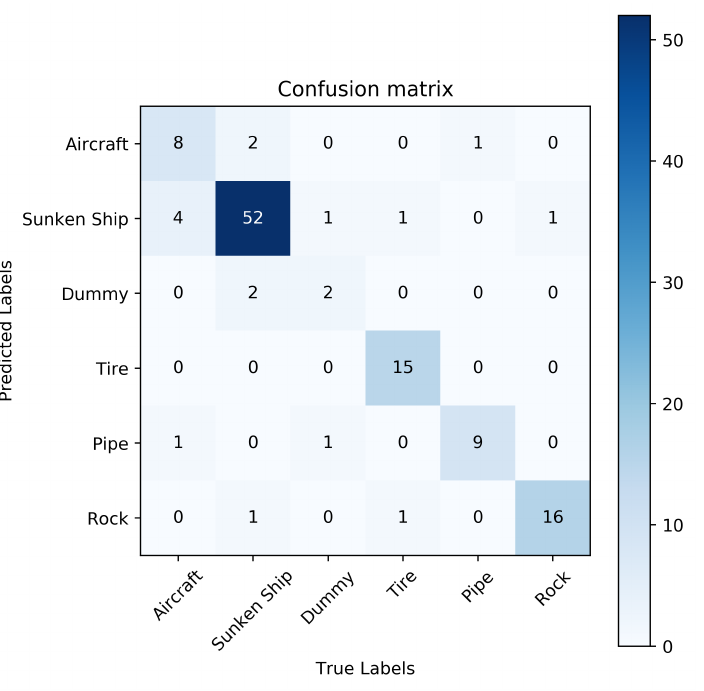
Figure 11. Confusion matrix of ResNet-ACW.